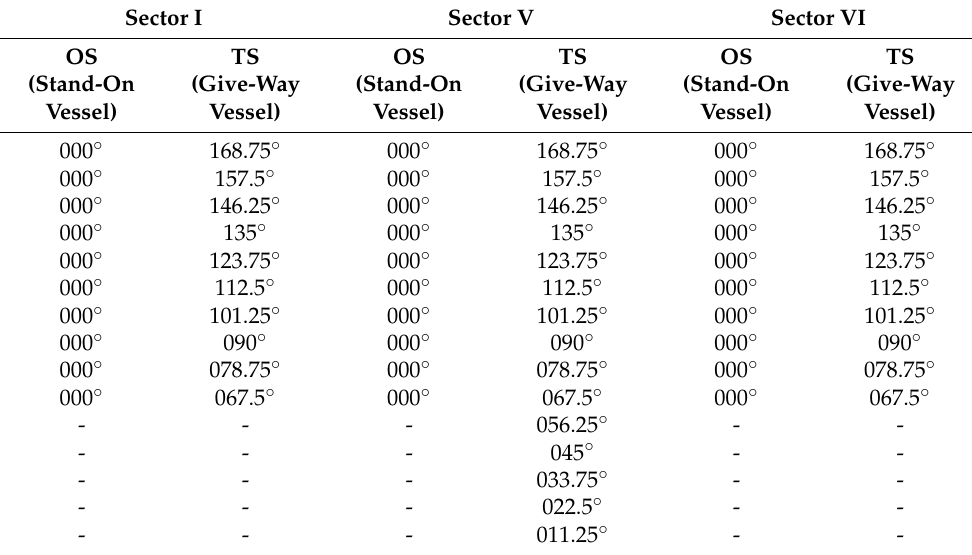
Table 2. Scenario for simulation between OS and